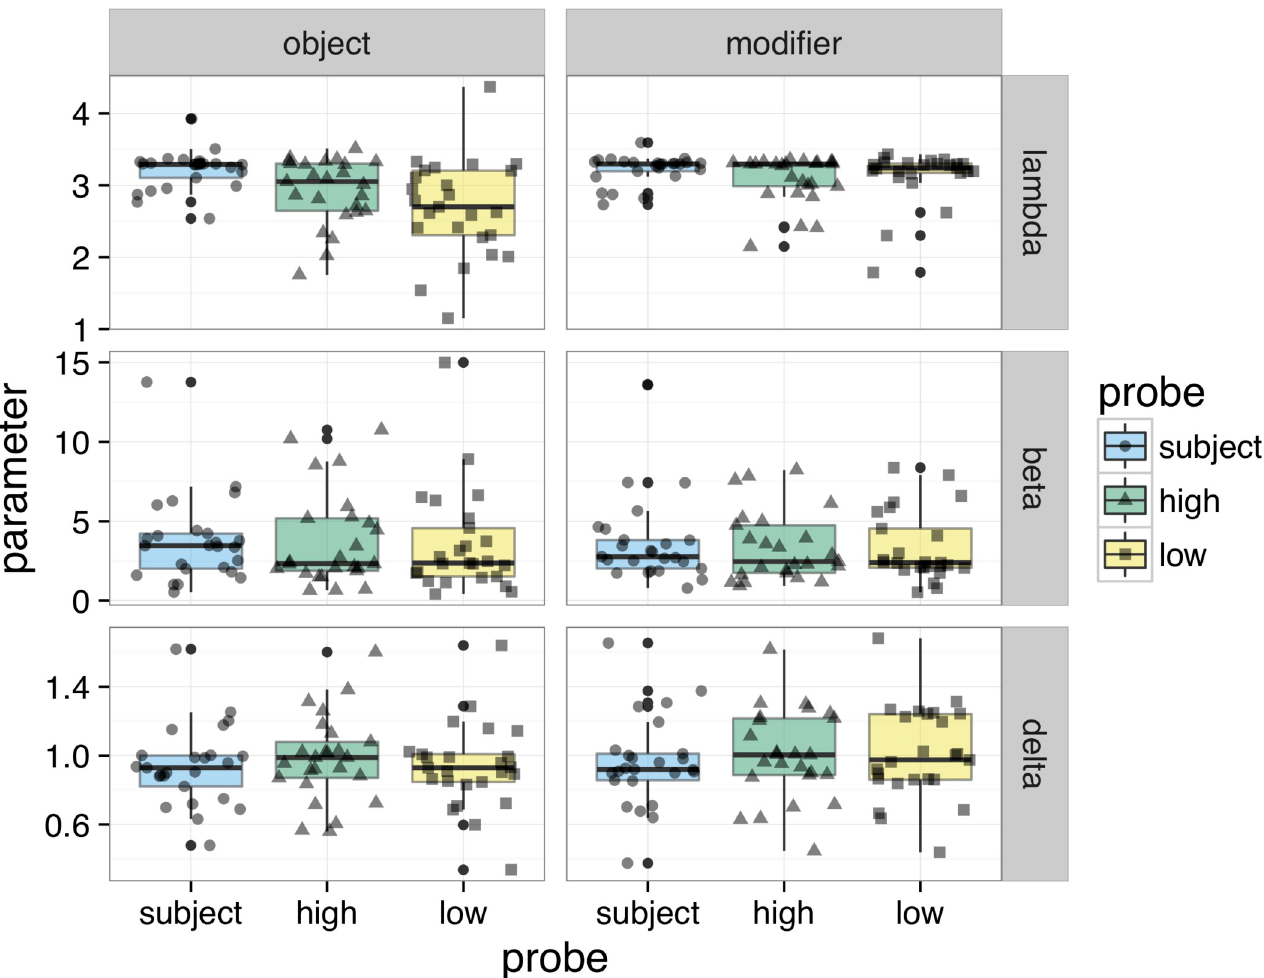
Fig 2. Experiment 2 participant SAT parameters. Box and scatter plots of individual parameter estimates for the asymptote, λ (d 0 ), rate, β (ms -1 ), and intercept, δ (ms).